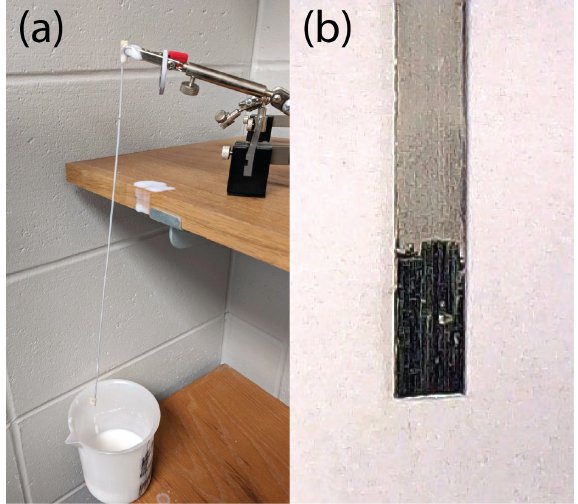
Figure 8. (a) An oxide layer is formed by dip coating with milk of magnesia, which forms magnesium oxide during heat treatment. (b) Close-up of a strip of cold-rolled permalloy strip showing milk of magnesia coating and a cleared region for welding.